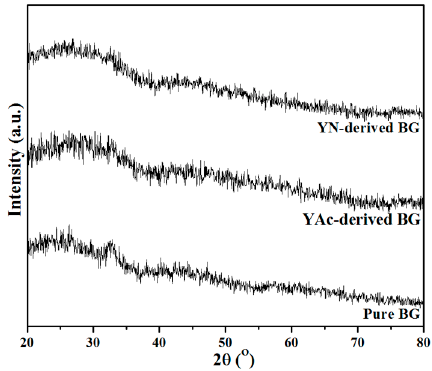
Figure 1. XRD patterns of pure BG powder, YAc-derived BG powder and YN-derived BG powder.